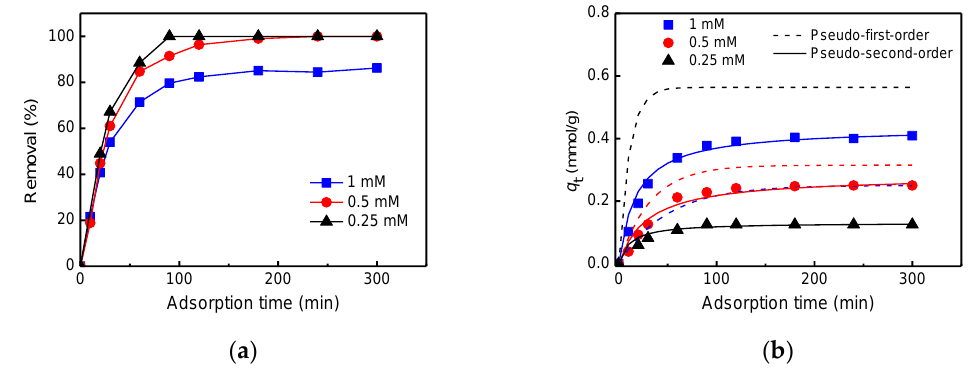
Figure 6. Changes in ( a ) removal efficiency of EDTA and ( b ) adsorption capacity of AERs from EDTA/Cs (1:1) with adsorption time. [AERs] = 2 g/L; [EDTA] = 0.25, 0.5, and 1 mM; pH = 7. Solid and dashed lines were fitted lines to determine adsorption order (related to Figure 12).